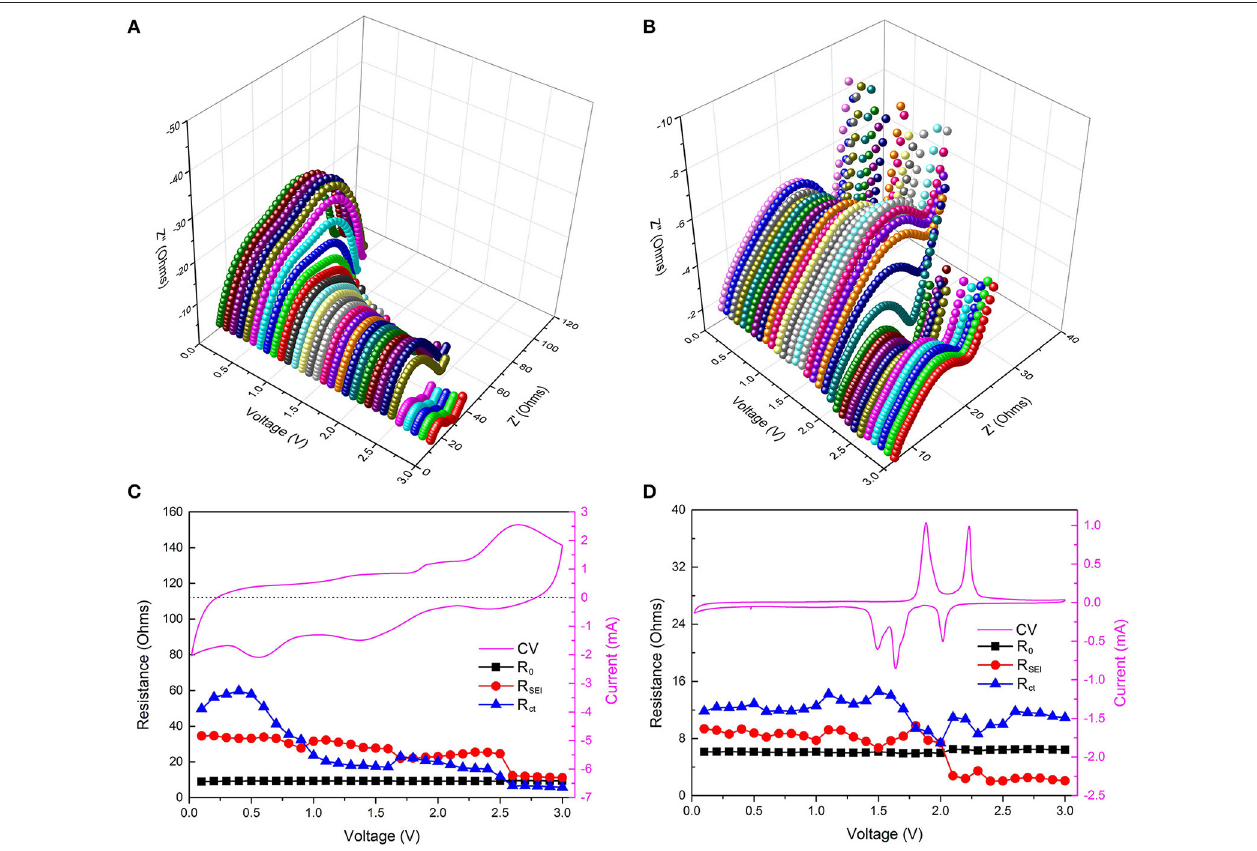
FIGURE 4 | (A,B) 3D Nyquist plots at different potentials after 200 cycles and 3 CV cycles; (C,D) show the corresponding fitting resistances at different potentials with the CV curves after 200 cycles and 3 CV